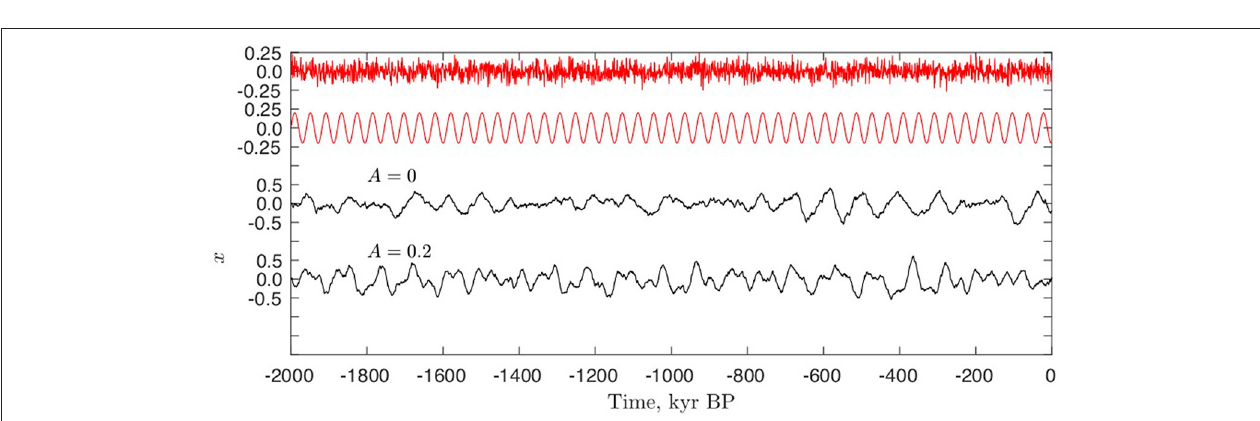
FIGURE 10 | Same as Figure 9 , but now keeping the parameter r = 0.25 constant at a value prior to the Hopf bifurcation, where the fixed point is stable. In this case stochastic terms ση x , ση y and ση z are added to the right hand side of (6), η x , y , z are unit variance Gaussian white noise and σ = 0.08, a corresponding noise curve is shown for illustration, (top red curve). This is on same time scale as the astronomical forcing with A = 0.2. Even with astronomical forcing, the internal 100 kyr oscillation dominates the climate signal x